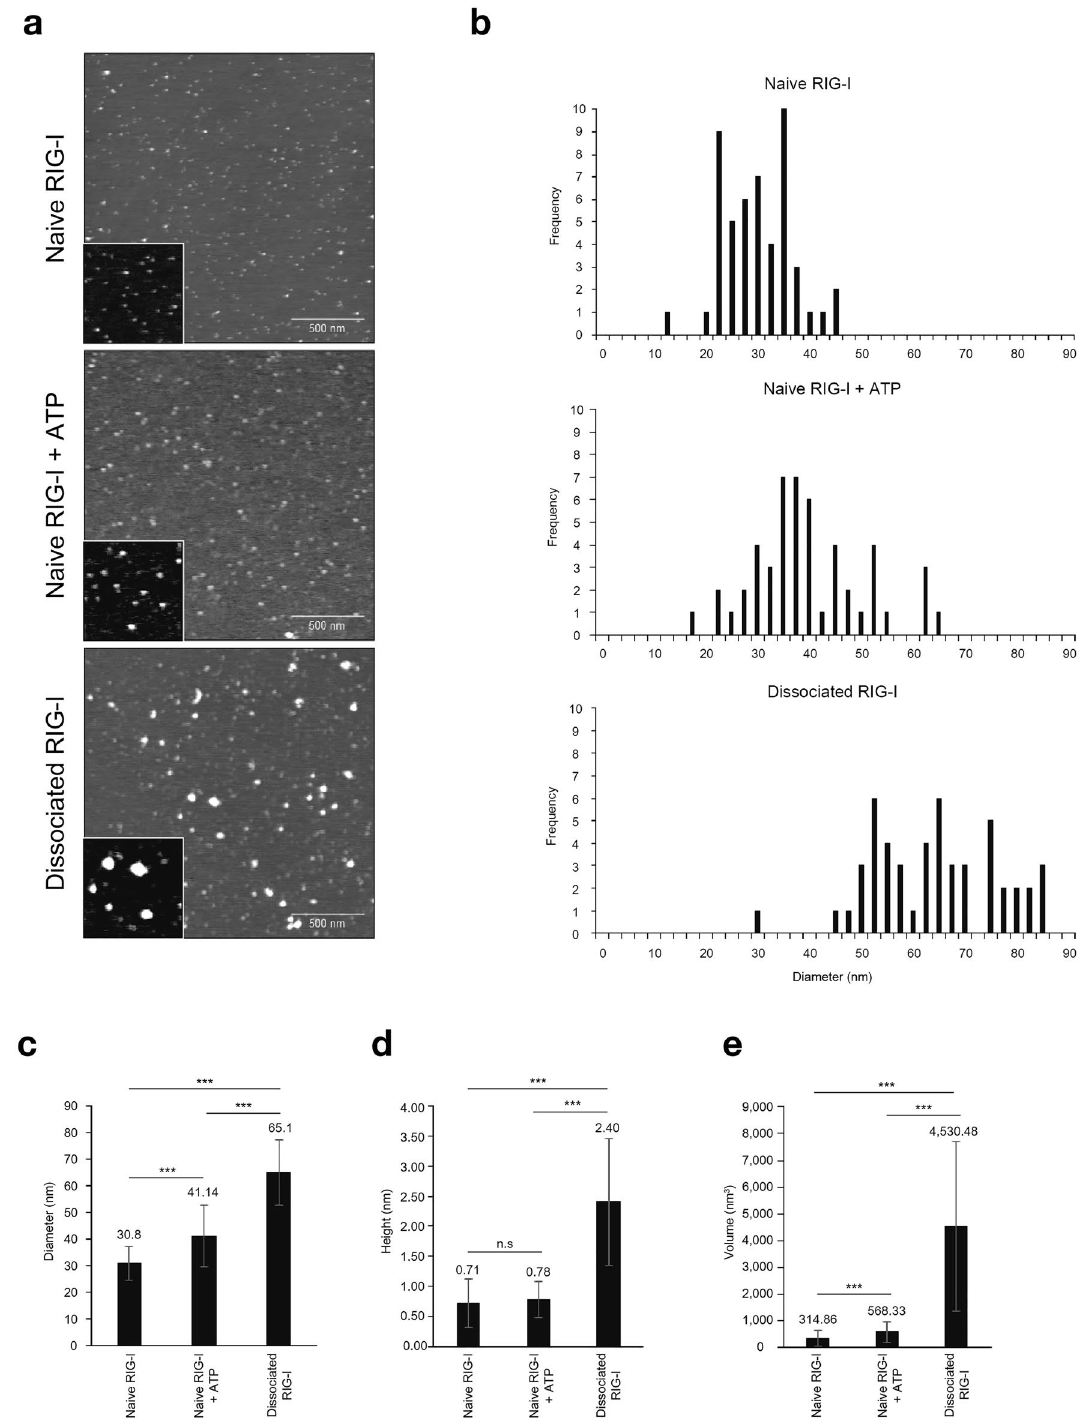
Figure 3. Morphological analysis of RIG-I protein by AFM. ( a ) Purified Flag-tagged RIG-I expressed in 293 T cells (naïve RIG-I, METHODS) was analyzed by AFM (top). Naïve RIG-I was incubated with 1 mM ATP (middle). Naïve RIG-I was bound to immobilized LMW poly (I:C) and incubated with 1 mM ATP for 30 min and released RIG-I (dissociated RIG-I) was recovered and subjected to AFM analysis (bottom). Enlarged images are shown as inset (500 × 500 nm 2 ). ( b ) The diameter of objects observed by AFM were measured and plotted as histogram. Average diameter ( c ), height ( d ) and volume ( e ) were similarly determined. Error bars represent standard deviation (n = 50). *** P < 0.001, unpaired Student’s t -test. n.s, not